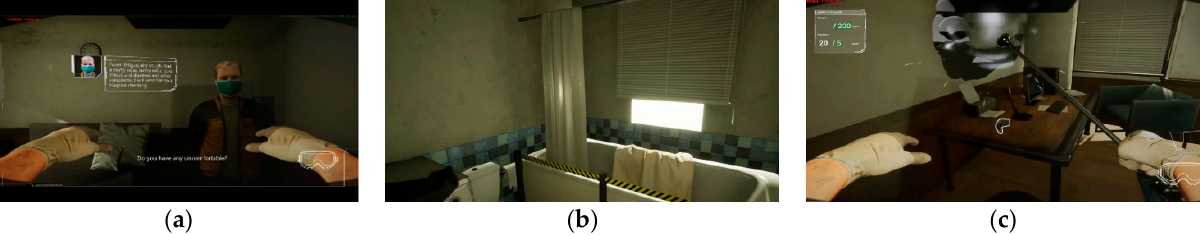
Figure 13. Investigation Module Implementation: ( a ) Close Contact Investigation [9]; ( b ) Sample Collection in bathroom [9]; ( c ) Environment Cleaning [9].